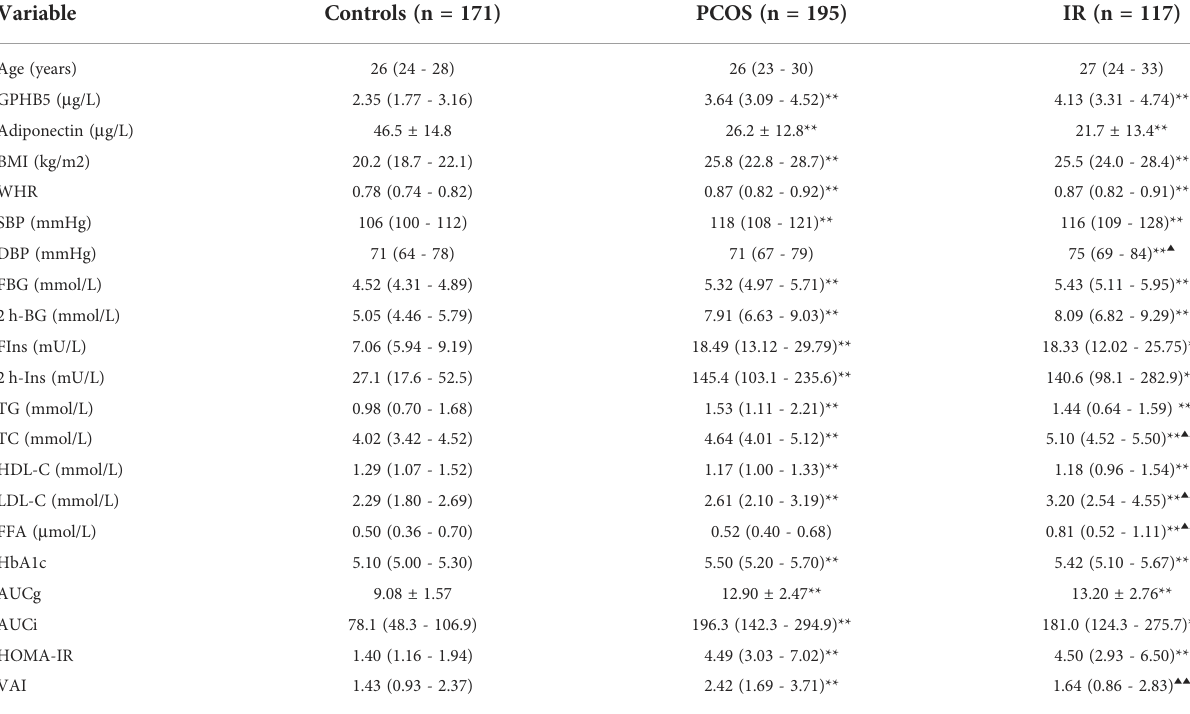
TABLE 1 Main clinical features and circulating GPHB5 levels in all study population.